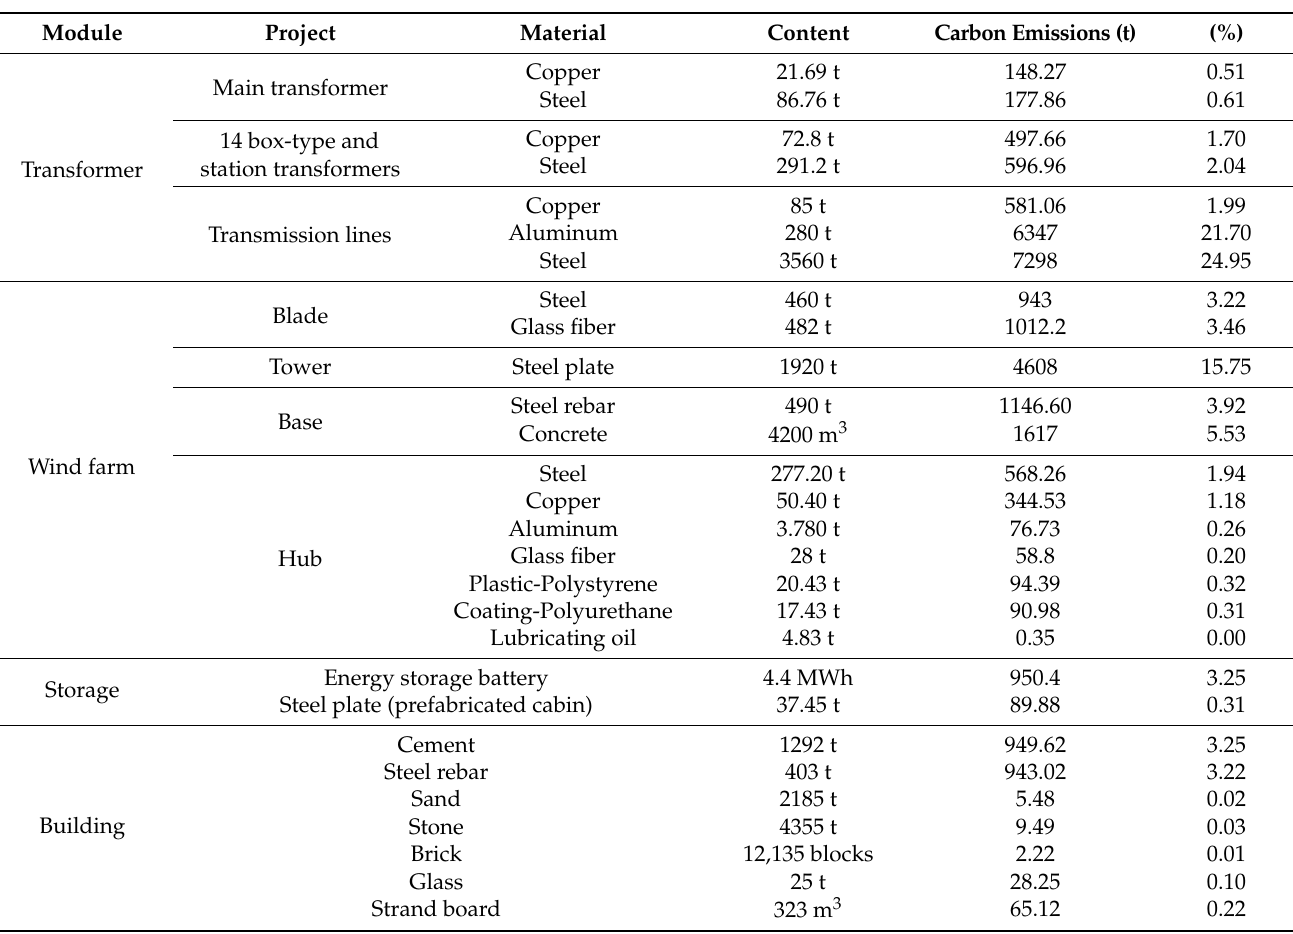
Table 5. Carbon emissions in the production and materialization